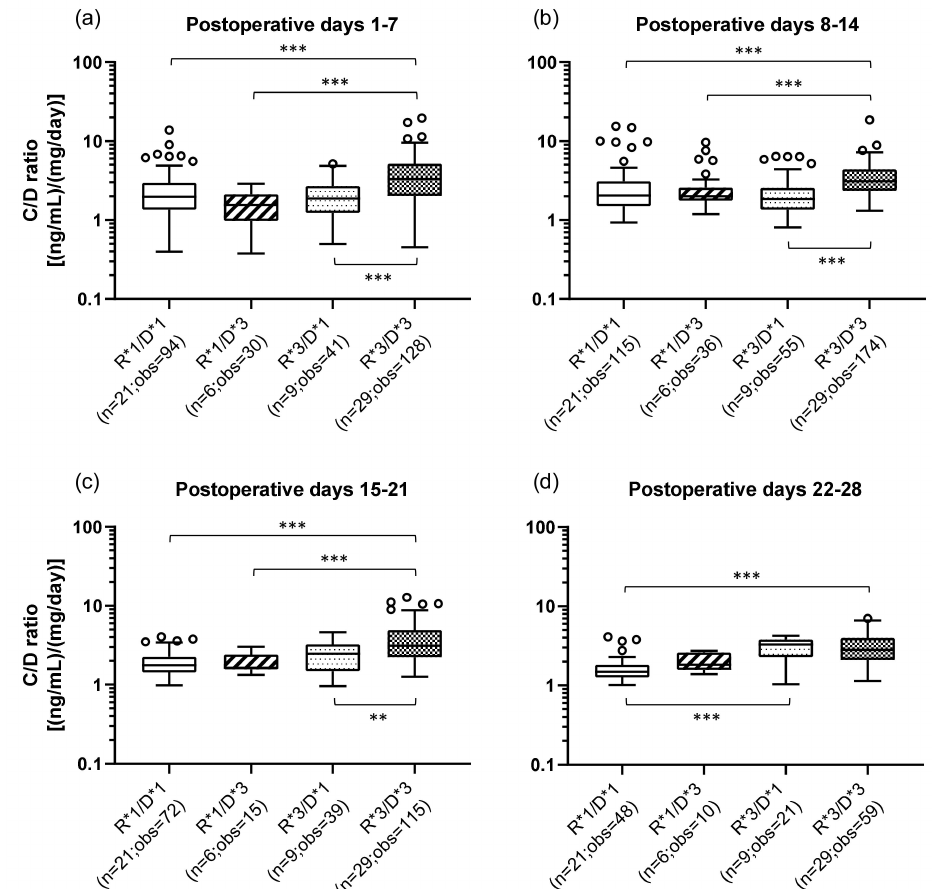
Figure 2. Influence of the combination of the recipient’s and donor’s CYP3A5 genotypes on the C / D ratio of tacrolimus on postoperative days 1–28 after living-donor liver transplantation. The patient groups were divided into four groups by the recipient’s and donor’s CYP3A5 polymorphism (R, recipient; D, donor; *1, CYP3A5*1 / *1 and CYP3A5*1 / *3 ; *3, CYP3A5*3 / *3 ). The C / D ratios of tacrolimus were compared for days 1–7 ( a ), 8–14 ( b ), 15–21 ( c ), and 22–28 ( d ) after transplantation. The bar indicates the median tacrolimus C / D ratio for each group, and boxes represent the 25th and 75th percentiles of the data. The whiskers represent the lowest and highest values that fall within 1.5 times the interquartile range of the lower and upper quartiles, respectively. ** p < 0.01 and ***p < 0.001 between groups. n, Number of patients; obs, number of observations i.e., number of tacrolimus